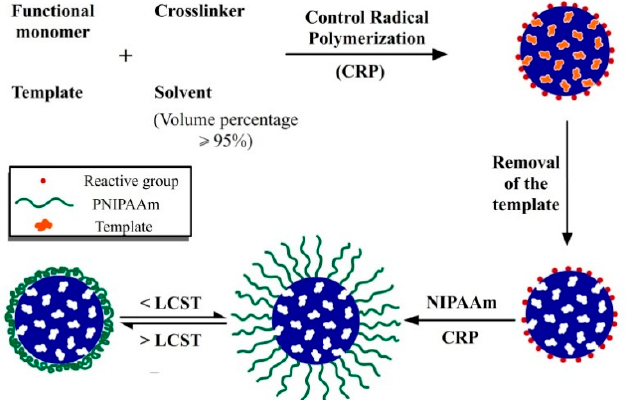
Figure 3. Protocol for the preparation of water-compatible and stimuli-responsive MIP microspheres with surface-grafted functional polymer brushes. Reprinted with permission from Reference 36. Copyright 2010, Elsevier.